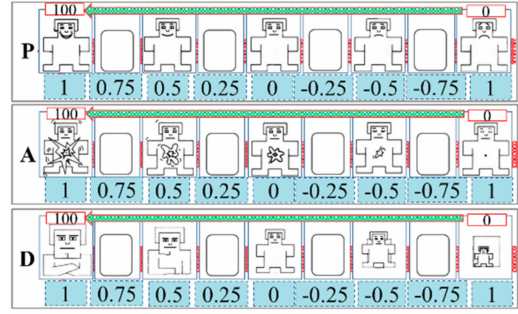
Figure 11. PAD emotion